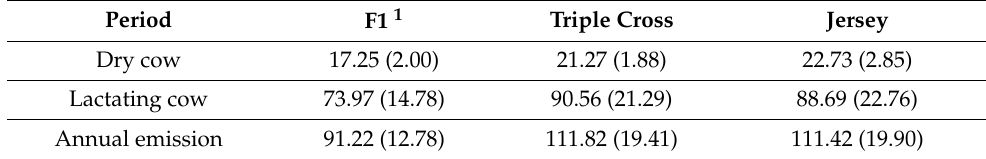
Table 4. Annual emission of enteric CH 4 in cows according to breed group (kg cow − 1 ) (mean + sd).